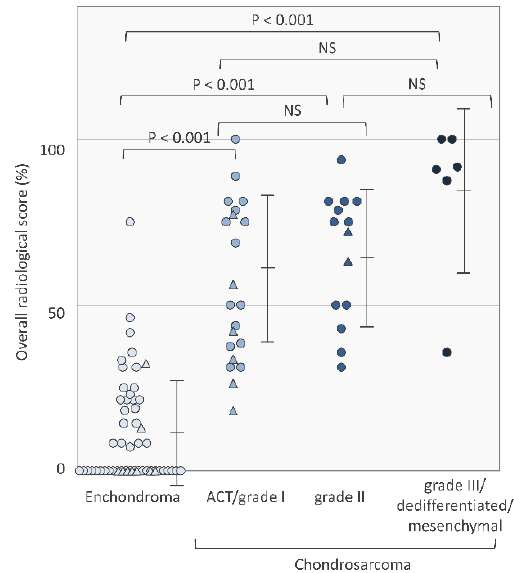
Figure 2. Overall radiological score rates in enchondroma, ACT/grade I chondrosarcoma, grade II chondrosarcoma, and grade III/dedifferentiated/mesenchymal chondrosarcomas. Overall radiological score rates were 11.6 ± 16.2% in patients with enchondroma, 62.1 ± 22.7% in patients with ACT/grade I chondrosarcoma, 64.7 ± 21.2% in patients with grade II chondrosarcoma, and 84.3 ± 24.3% in patients with grade III/dedifferentiated/mesenchymal chondrosarcoma, respectively. Data points with a circle shape are the development cohort and data points with a triangle shape are the validation cohort. Values are expressed as means ± SD. NS: not significant.